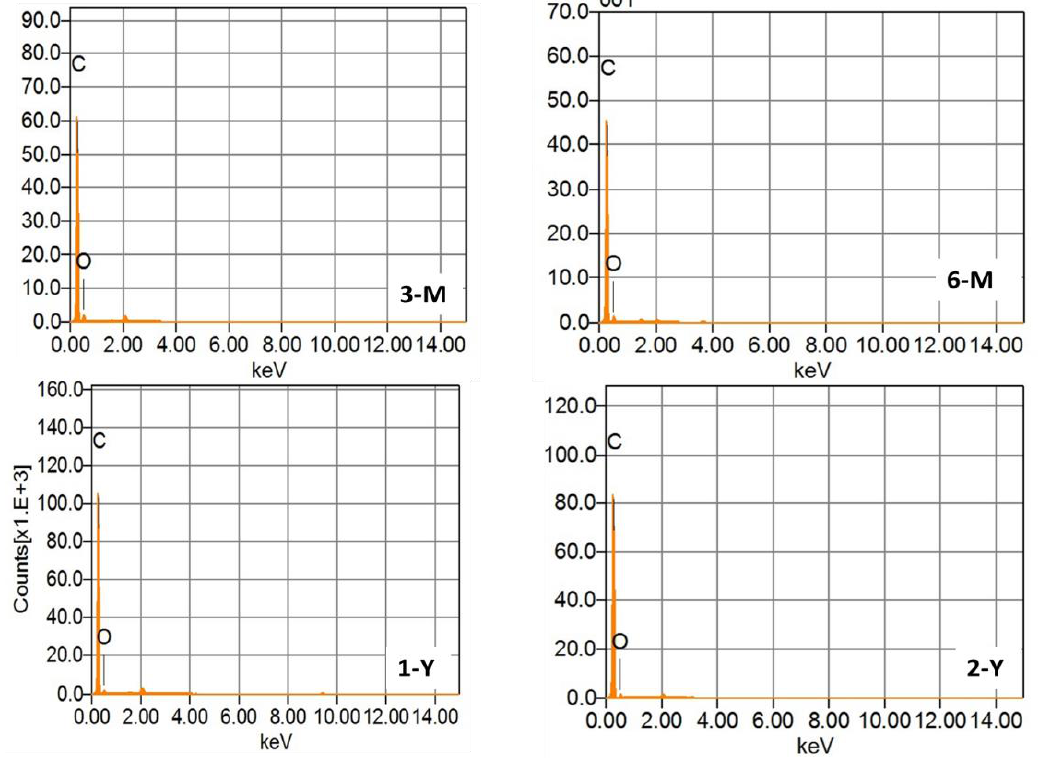
Figure 7. Energy dispersive X-ray analysis (EDX) spectrums of four BW samples with different stor- age times.